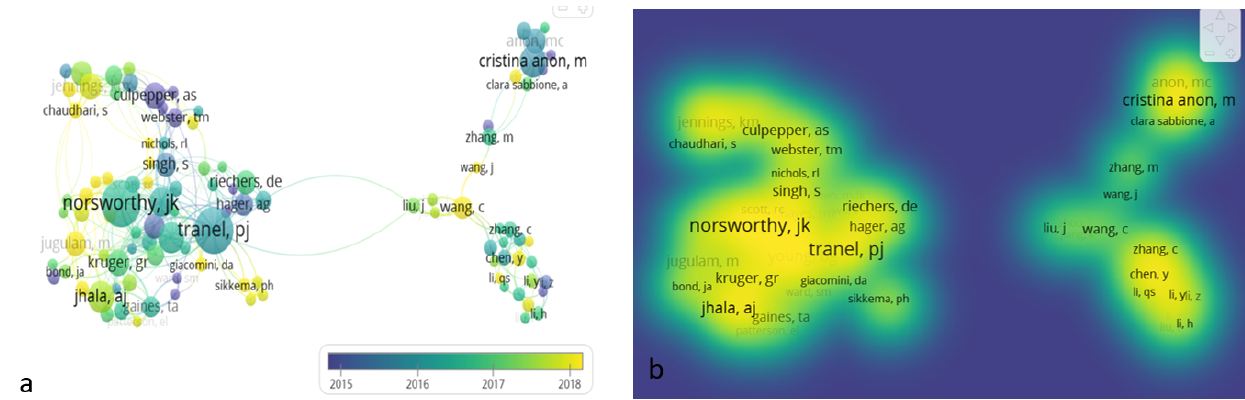
Figure 4. “Co-authorship” authors on Amaranthus research. Overlay visualization ( a ), density visualization ( b ). Co-authorship institutions.